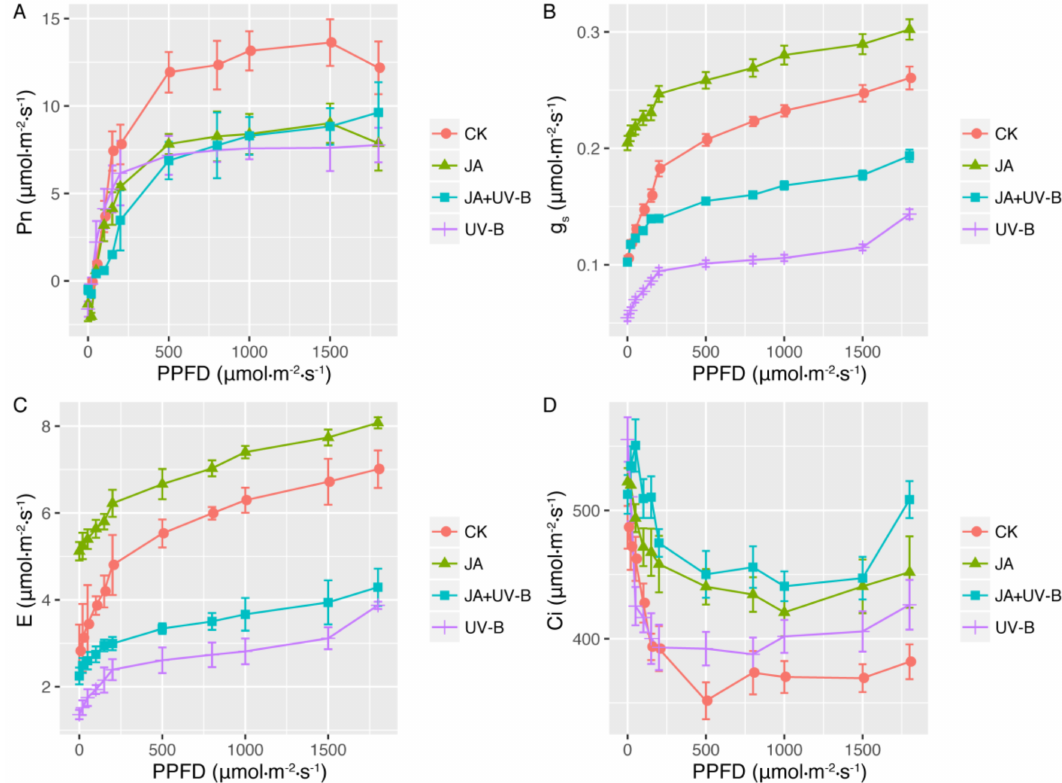
Figure 1. The curves of the response of net photosynthetic rate (Pn) ( A ), stomatal conductance (gs) ( B ), transpiration rate (E) ( C ) and intercellular CO 2 concentration (Ci) ( D ) to photosynthetic photon flux density (PPFD) for Scutellaria baicalensis Georgi under different treatments. CK (the control), JA (seedlings were sprayed with 1 mM jasmonic acid (JA)), UV-B (seedlings were treated with 15-d elevated ultraviolet-B (UV-B) radiation), JA+UV-B (seedlings were sprayed with 1 mM JA before additional 15-d UV-B radiation). Measurements were made from 0 to 1800 µ mol · m − 2 · s − 1 . Each point represents the mean value of 3 leaves from 3 seedlings. Data are means ±